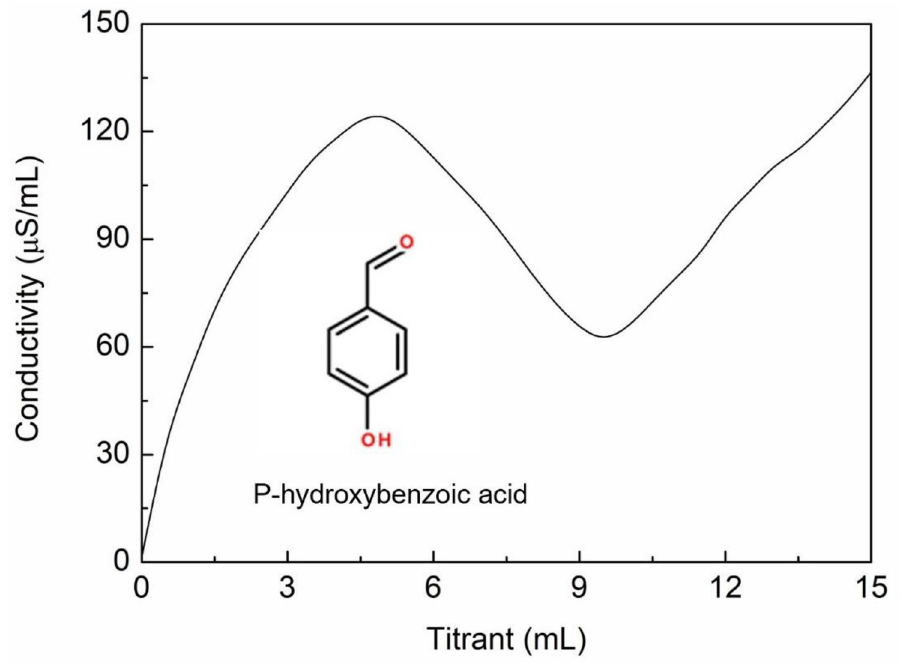
Fig 9. Conductivity curve for p-Hydroxybenzoic acid.